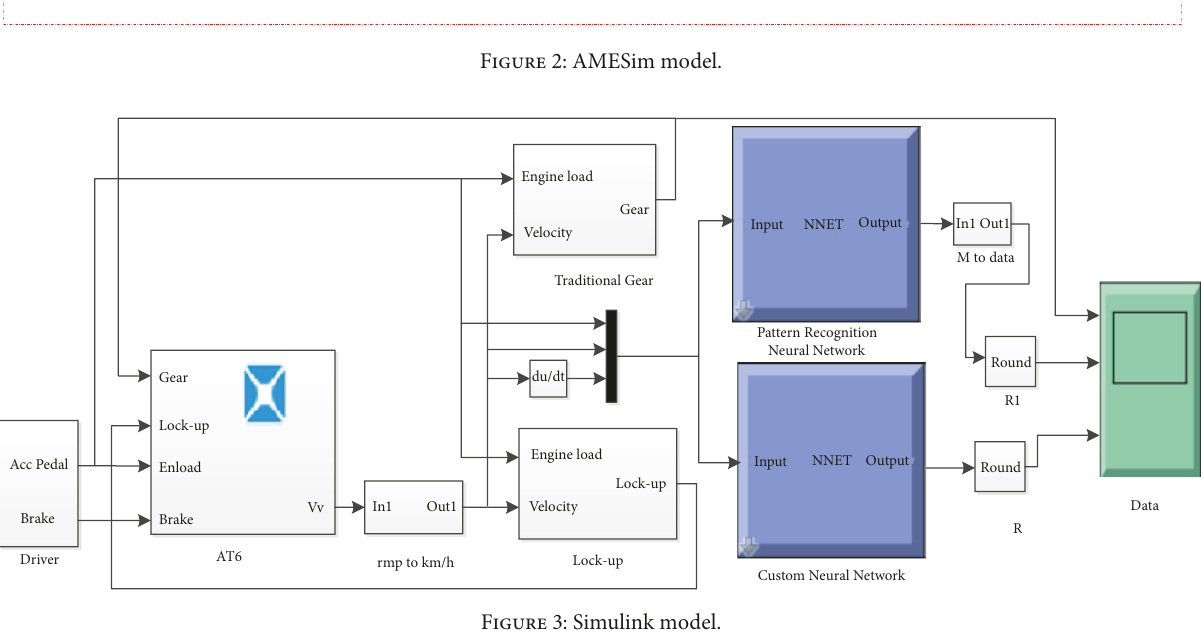
Figure 3: Simulink